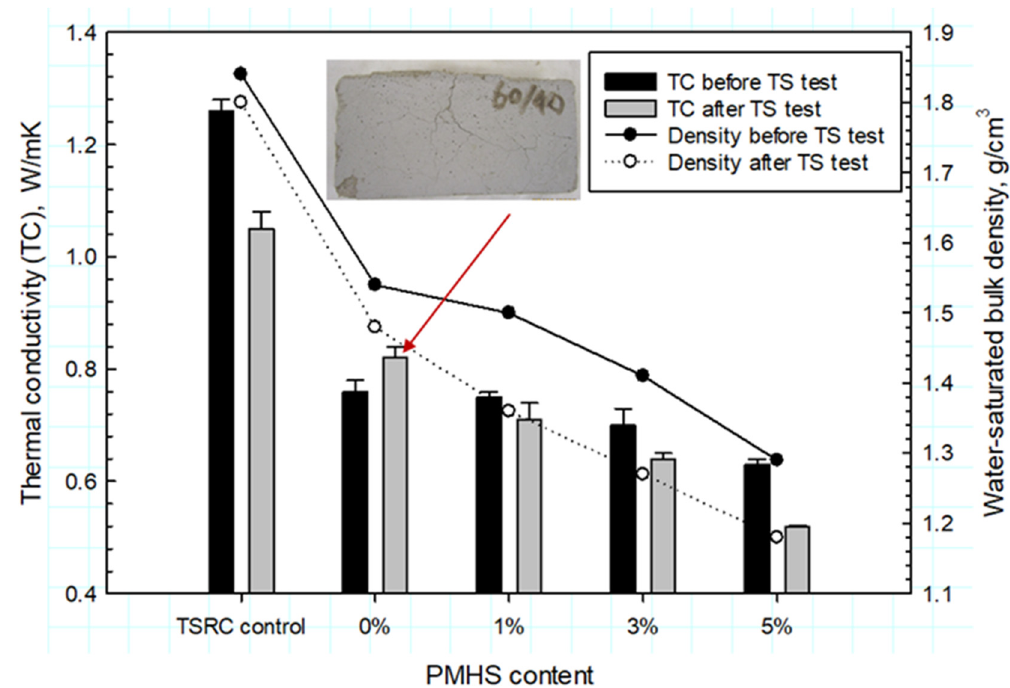
Figure 21. Thermal conductivity and water-saturated bulk density for 250 ◦ C-autoclaved TSRC control, and CAC lightweight cements containing 1, 3, and 5% PMHS-treated and untreated FCSs before and after the TS test.